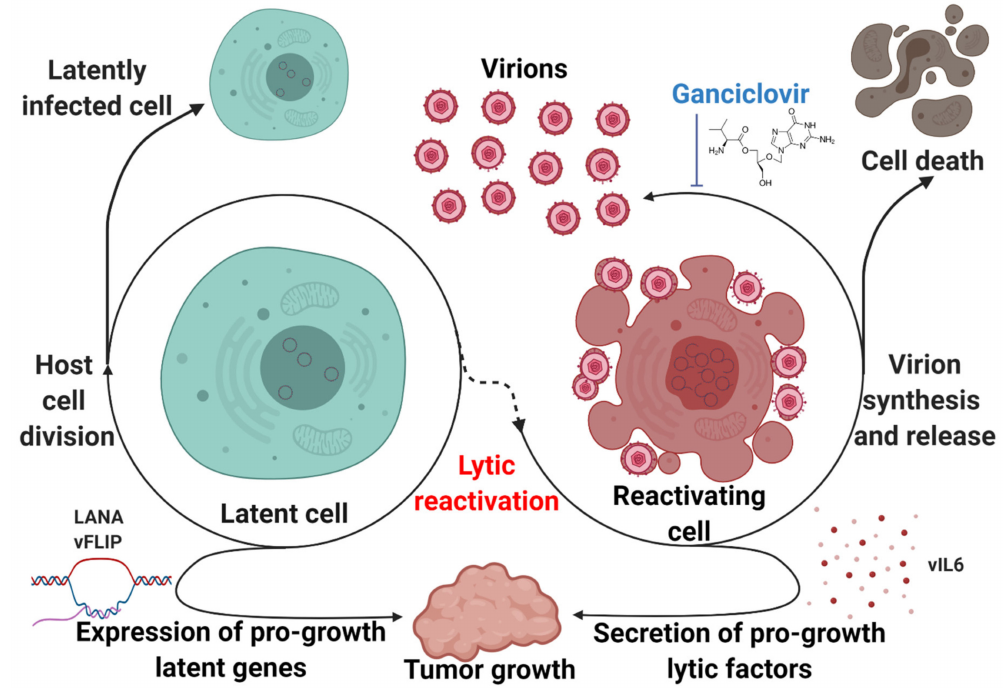
Figure 4. The latent and lytic stages of the KSHV life cycle drive pathogenesis. Latency maintains a population of infected cells by segregating KSHV episomes to daughter cells after mitosis. Lytic reactivation produces infectious virions that expand the pool of infected cells. Both latent and lytic factors promote tumor growth through viral oncogenes or paracrine factors. Lytic replication is sensitive to chemical inhibition, while latent episomes are di ffi cult to target. Therapeutic interventions can force the virus out of latency, promoting cell